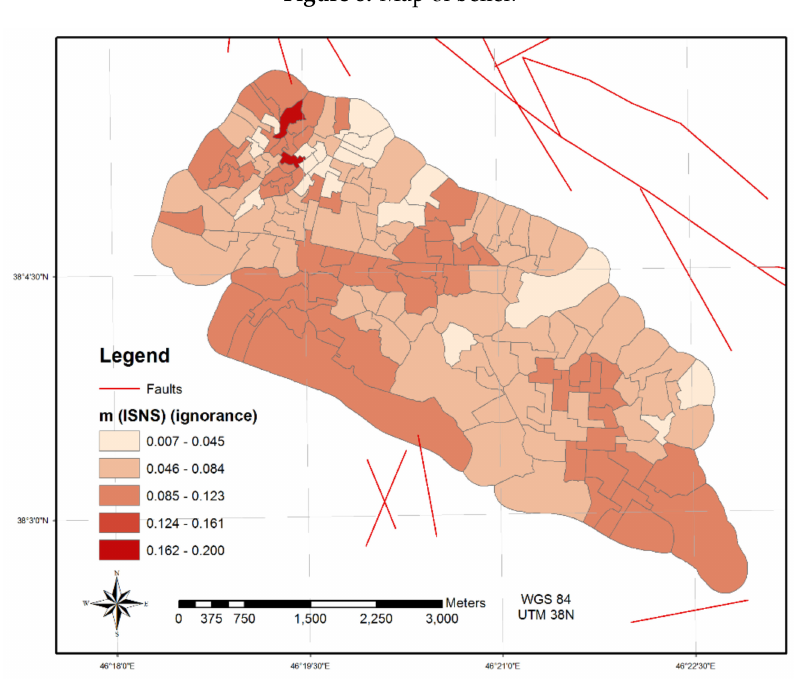
Figure 8. Map of belief.